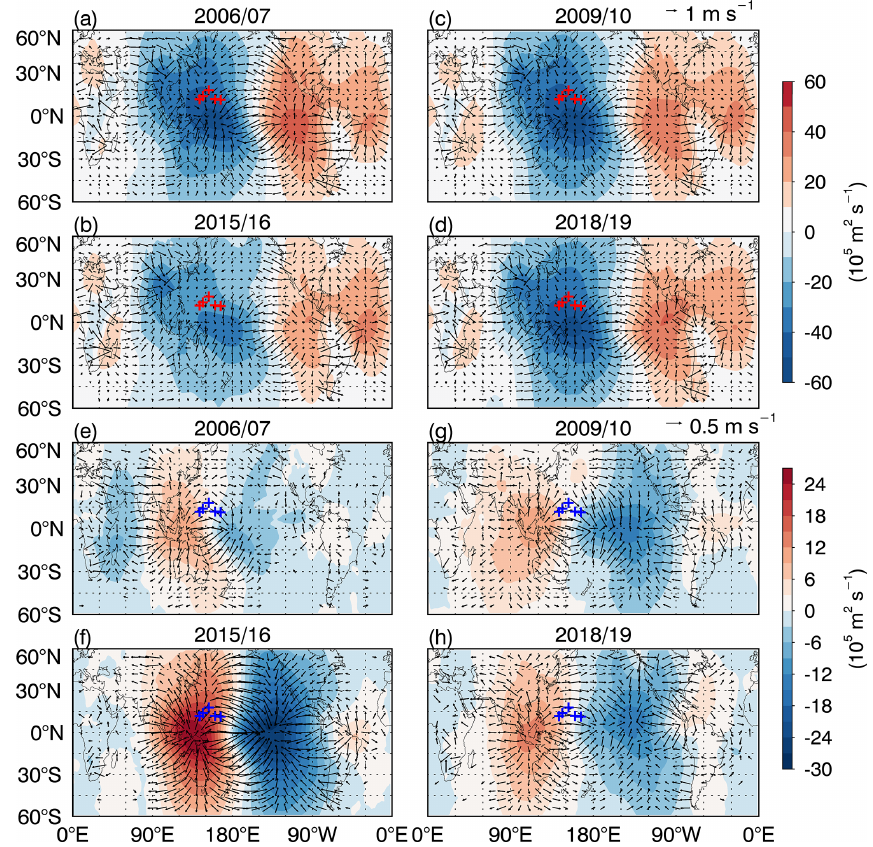
Figure 7. Velocity potential(shading) and divergent wind (arrows) of the Walker circulation and their anomalies at 850hPa in the (a, e) 2006/07, (b, f) 2015/16, (c, g) 2009/10, and (d, h) 2018/19 winters. Panels (a–d) show the velocity potential and divergent wind, and panels (e–h) show their anomalies. The red and blue pluses denote the five radiosonde